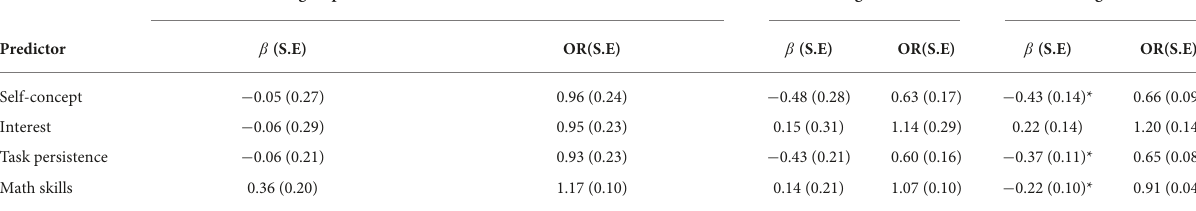
TABLE 6 Predictors of transition groups from grade 6 to 9. Combinedgroupoflowcontrolandtransitiontolowcontrol